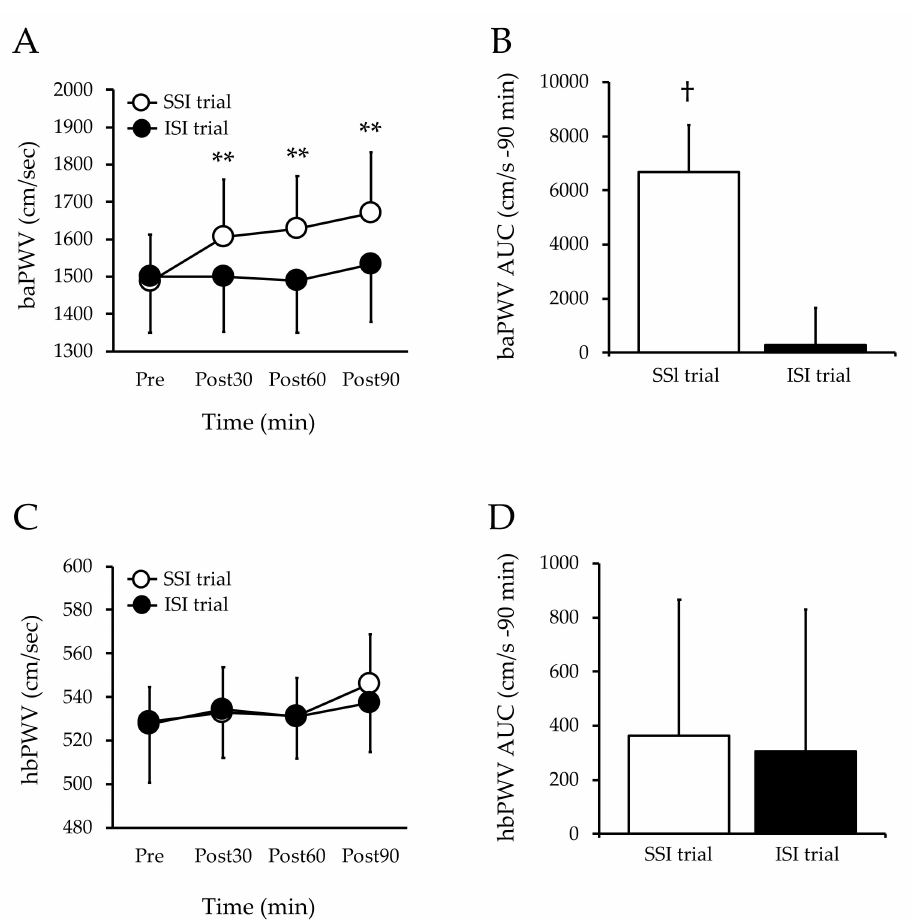
Figure 2. Changes in arterial stiffness at baseline and post-ingestion in both trials. Values are mean ± SD. ** p < 0.01 vs. baseline. † p < 0.01 vs. ISI trial. baPWV, brachial–ankle pulse wave velocity; hbPWV, heart–brachial pulse wave velocity; SSI, sucrose solution intake; ISI, isomaltulose solution intake; AUC, area under the curve; SD, standard deviation; Figure A, baPWV; Figure B, baPWV AUC; Figure C, hbPWV; Figure D, hbPWV